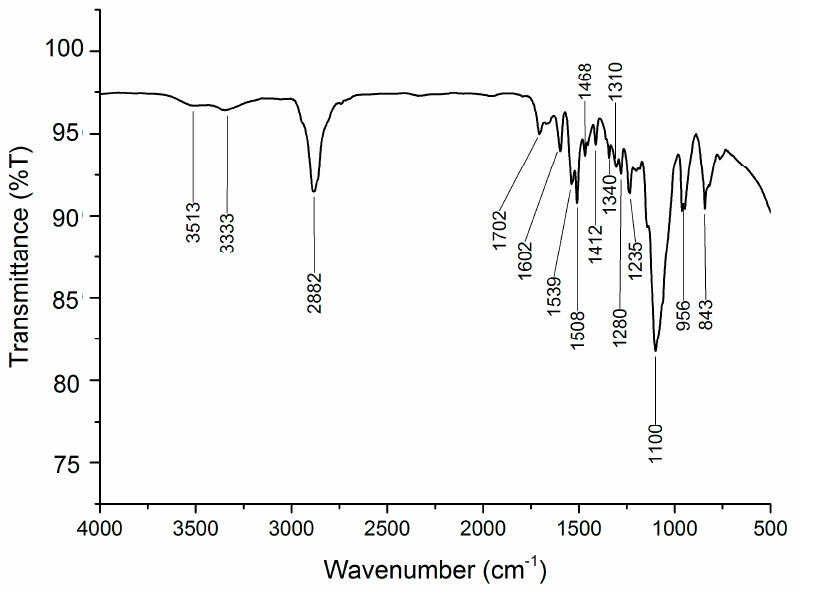
Figure 1. ATR − FTIR analysis of PU − PEG 10,000.